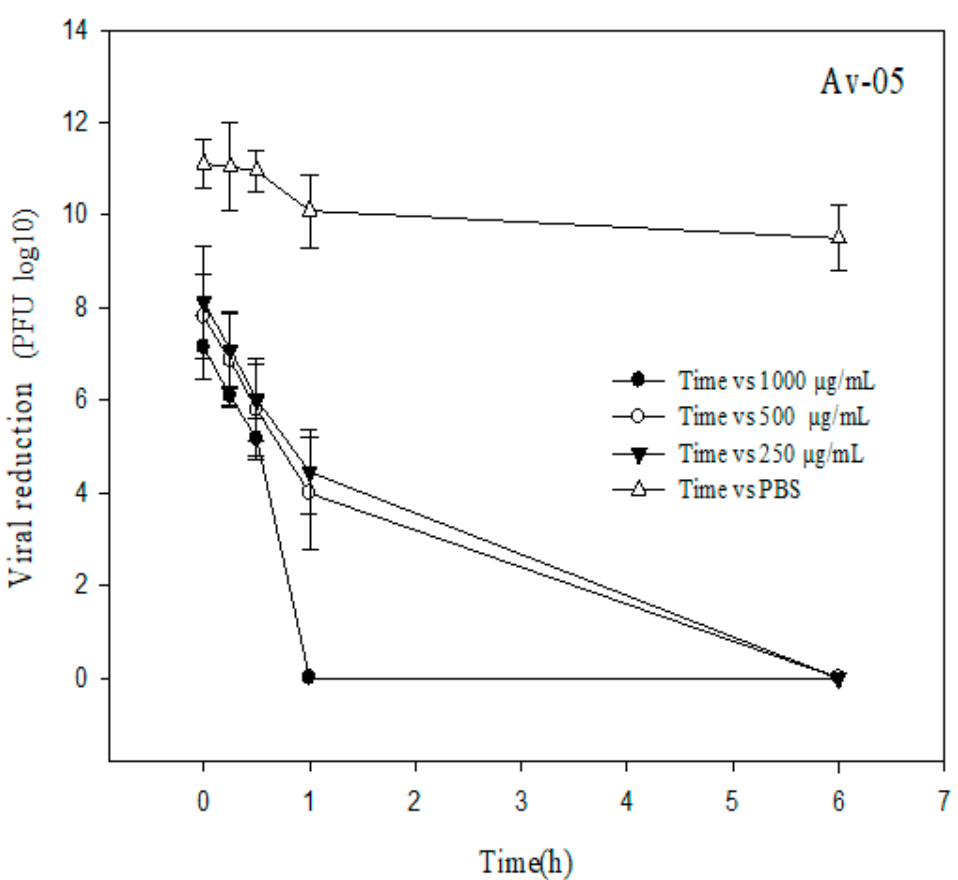
Figure 2. Reduction of Av-05 (PFU / mL log10) after treatment with AEE for various contact times (0, 15, 30, 60 and 360 min) at three concentrations (250, 500 and 1000 µ g / mL). The vertical error bars represent the standard deviation (SD). Phosphate-bu ff ered saline (PBS) is the control.